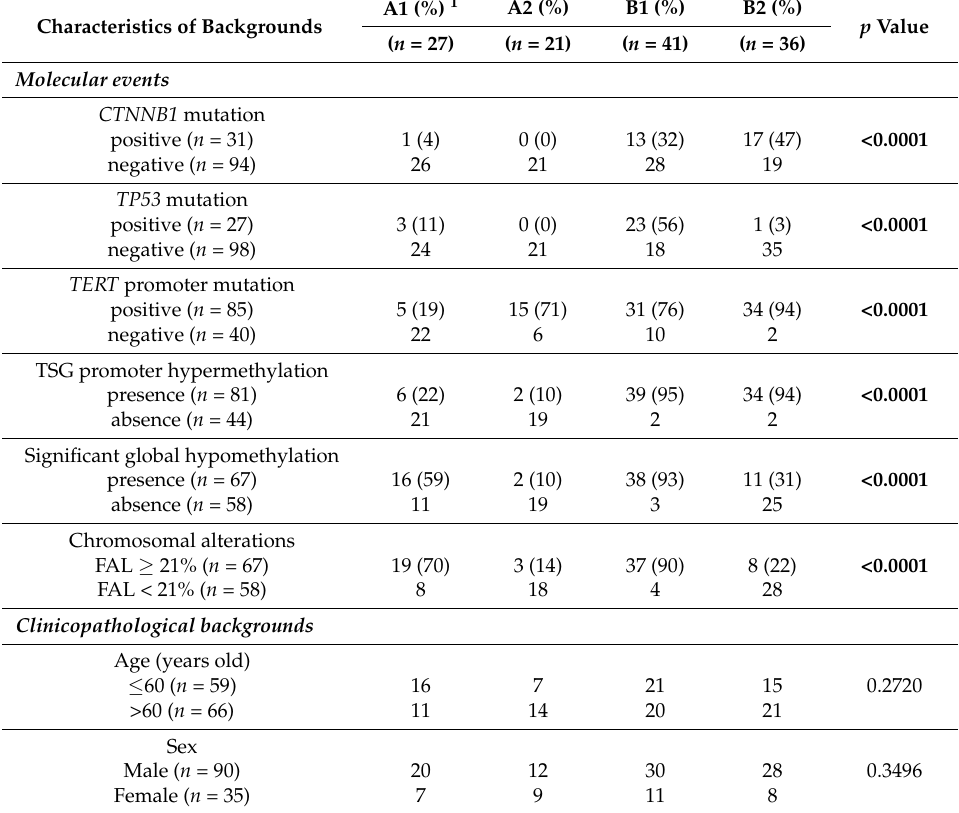
Table 3. Classification of HCCs based on the molecular alterations and clinical